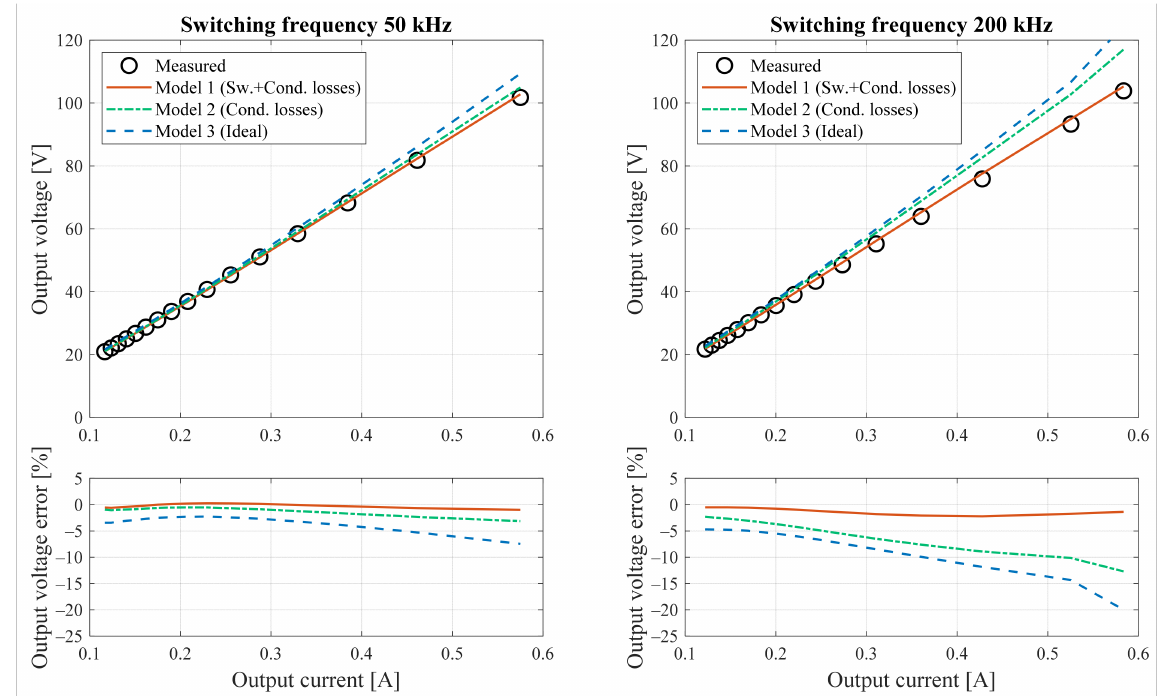
Figure 18. Predicted output voltage and relative error for known input voltage, input current and output current at switching frequencies e = 50 kHz and 200